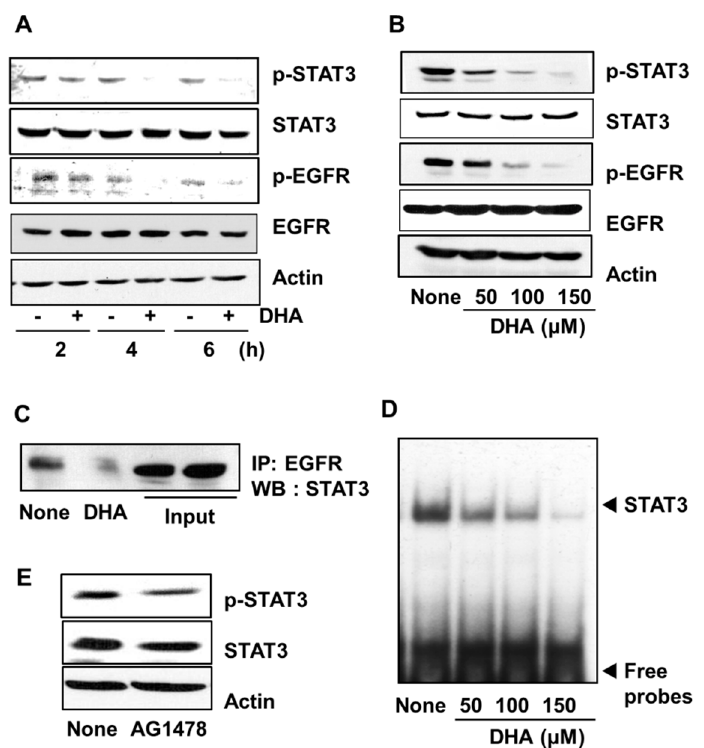
Figure 3. Effect of DHA on the levels of phospho (p)-STAT3, STAT3, p-EGFR, and EGFR, the interaction of EGFR and STAT3, STAT3 DNA-binding activity, and the effect of AG1478 on p-STAT3 and STAT3 levels in PANC-1 cells. Cells were treated with 150 μ M DHA for various time periods ( A ) and with 50, 100, and 150 μ M DHA for 4 h ( B – D ). The cells were treated with 10 μ M tyrophostin AG1478 for 4 h ( E ). ( A ) Plot of the protein levels of p-STAT3, STAT3, p-EGFR, and EGFR (and the protein standard actin) in the cells treated with 150 μ M DHA for 2, 4, and 6 h. “-” means without DHA treatment and “+” represents with DHA treatment. ( B ) Plot of the protein levels of p-STAT3, STAT3, p-EGFR, and EGFR (and the protein standard actin) in the cells treated for 4 h with the concentrations of DHA indicated. Column “None” corresponds to the extract from untreated cells, column “50”, “100”, and “150” to the extracts from cells treated with 50, 100, and 150 μ M DHA, respectively. ( C ) Western blot (WB) of PANC-1 cells treated with 150 μ M DHA for 4 h. The total cell lysates were immunoprecipitated (IP) with EGFR antibody and then immunoblotted (by Western blotting, WB) using STAT3 antibody. ( D ) DNA-binding activity of STAT3 in PANC-1 cells treated for 4 h with the indicated concentrations of DHA. The description of the columns is the same as in ( B ). ( E ) Plot of the protein levels of p-STAT3 and STAT3 (and the protein standard actin) in the cells treated with 10 μ M AG1478 for 4 h. The column labeled “None” corresponds to the extracts from untreated cells and the column labeled “AG1478” corresponds to the extracts from cells treated with 10 μ M AG1478. EGFR = epidermal growth factor receptor (EGFR); STAT3 = signal transducer and activator of transcription factor 3.